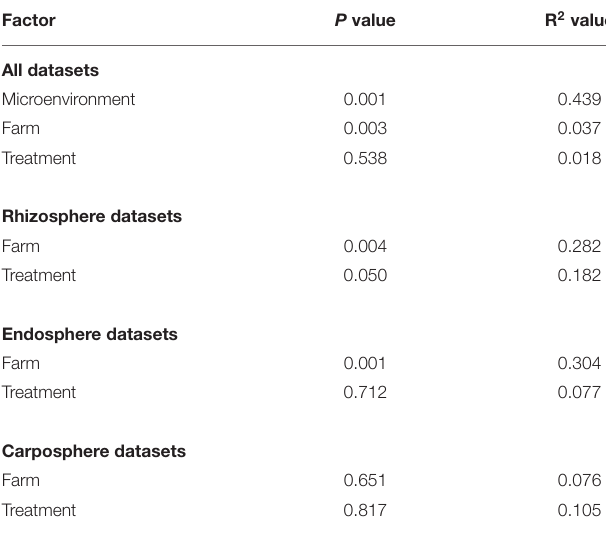
TABLE 1 | Permutational ANOVA (PERMANOVA) performed on the weighted Unifrac dissimilarity matrix showing influencing factors for the whole dataset and each